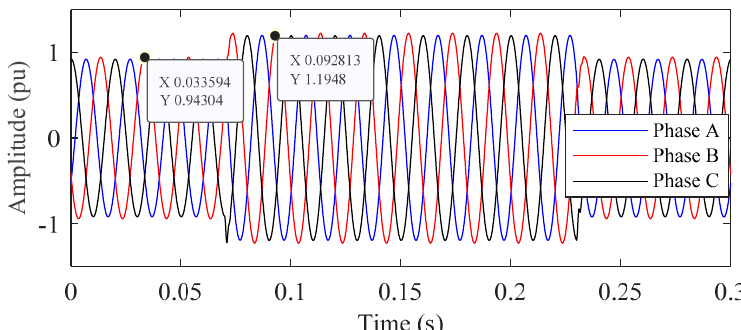
Figure 18. The voltage swell when the three-phase voltage increases from the grid.